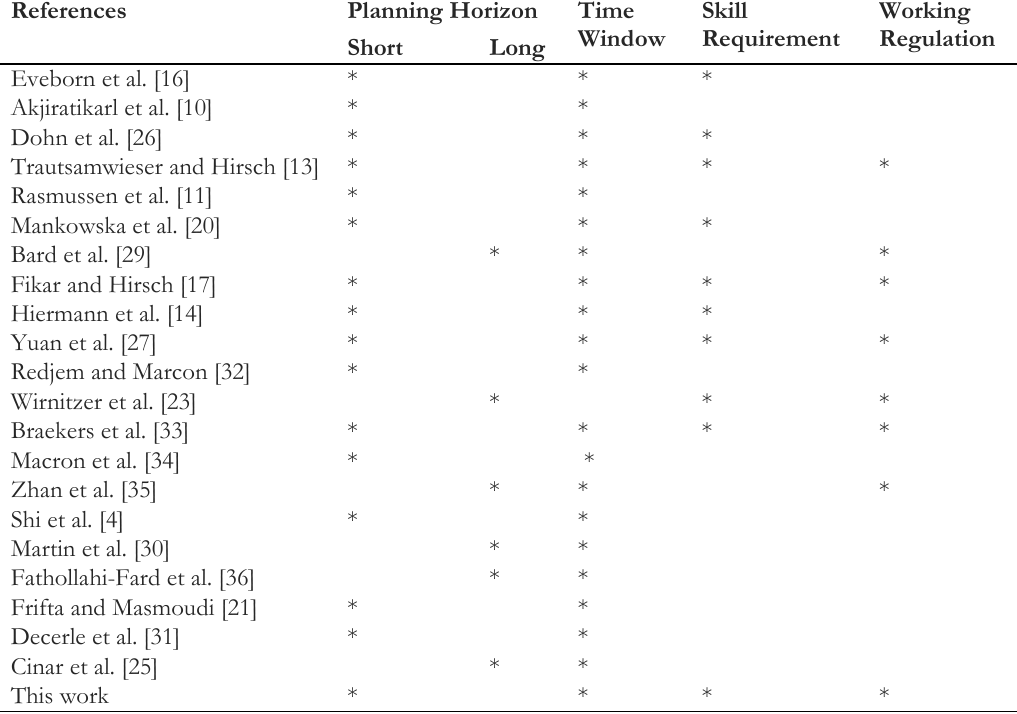
Table 1. Constraints of the HHC routing and scheduling problem in the